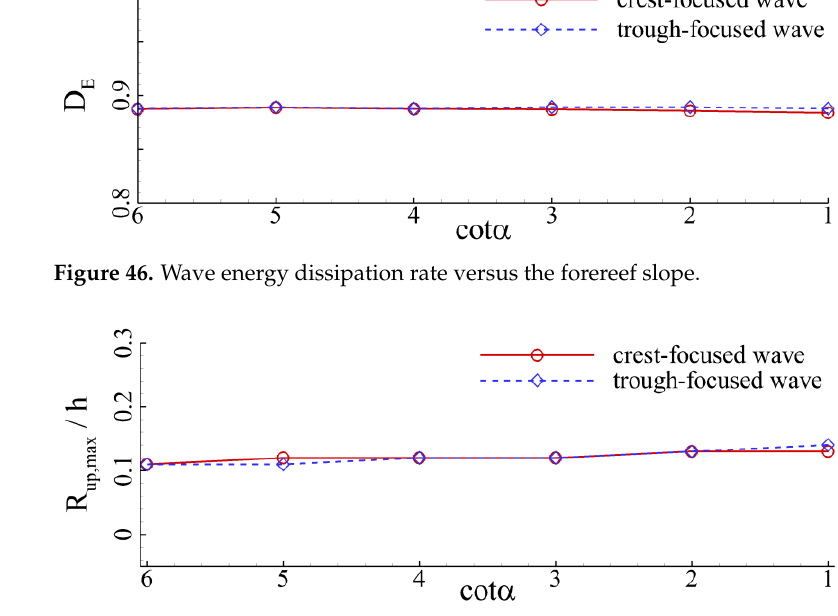
Figure 47. Maximum wave runup height versus the forereef slope.